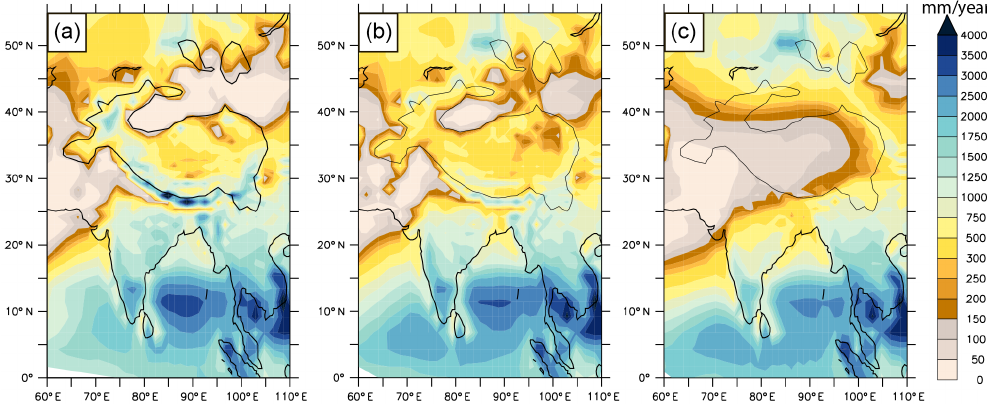
Figure 6. Annual mean precipitation amount (absolute values, mmyr − 1 ) for the following: (a) MOD case, (b) INT case, (c) LOW